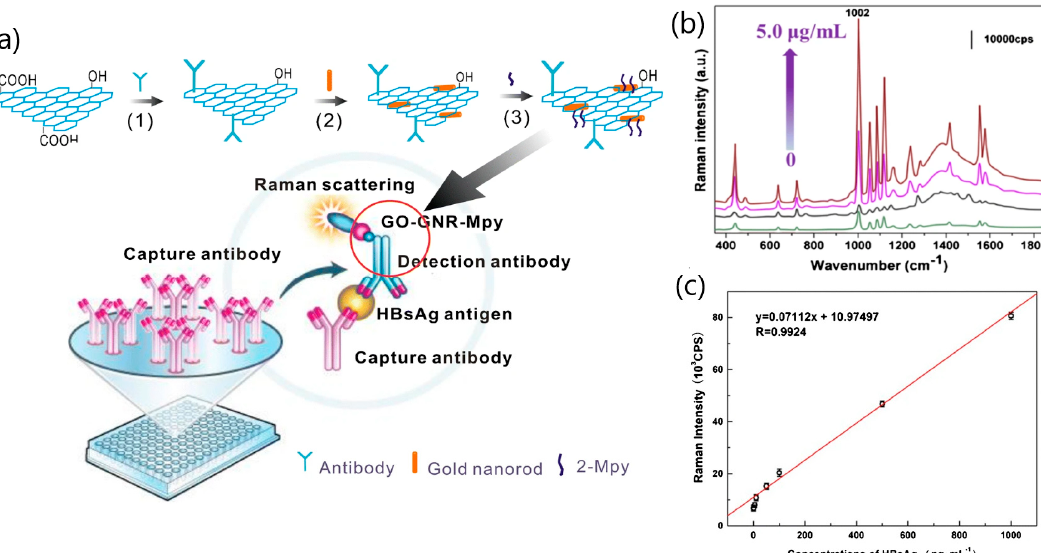
Figure 6. ( a ) Schematic illustration of Raman immunoassay based on graphene oxide gold nanorods (GO-GNRs). (1) GO was functioned by anti-HBsAg antibody. (2) GNRs were decorated on the surface of GO to form GO-GNRs’ composites. (3) The 2-mercaptopyridine (2-Mpy) was bound to the GNRs’ surface by forming the S-Au bond. ( b ) SERS assays of different concentrations of HBsAg based on the GO-GNR Raman immunosensor (the concentrations of HBsAg were 0.01 pg·mL − 1 (green), 1.0 pg·mL − 1 (black), 10 ng·mL − 1 (purple), and 5.0 μ g·mL − 1 (red); ( c ) the linear relationship of SERS intensity with HBsAg concentrations in the range of 1–1000 pg·mL − 1 . The accumulation time and laser power were set as 20 seconds and 1.0 mW for each spectrum, respectively. To determine the HBsAg contents more sensitively, the SERS signals of samples were collected with 785 nm Ar + ion laser sources. The data were collected by averaging five measurements. Adapted with permission from Miu et al. [45] Copyright © (2016) Springer.